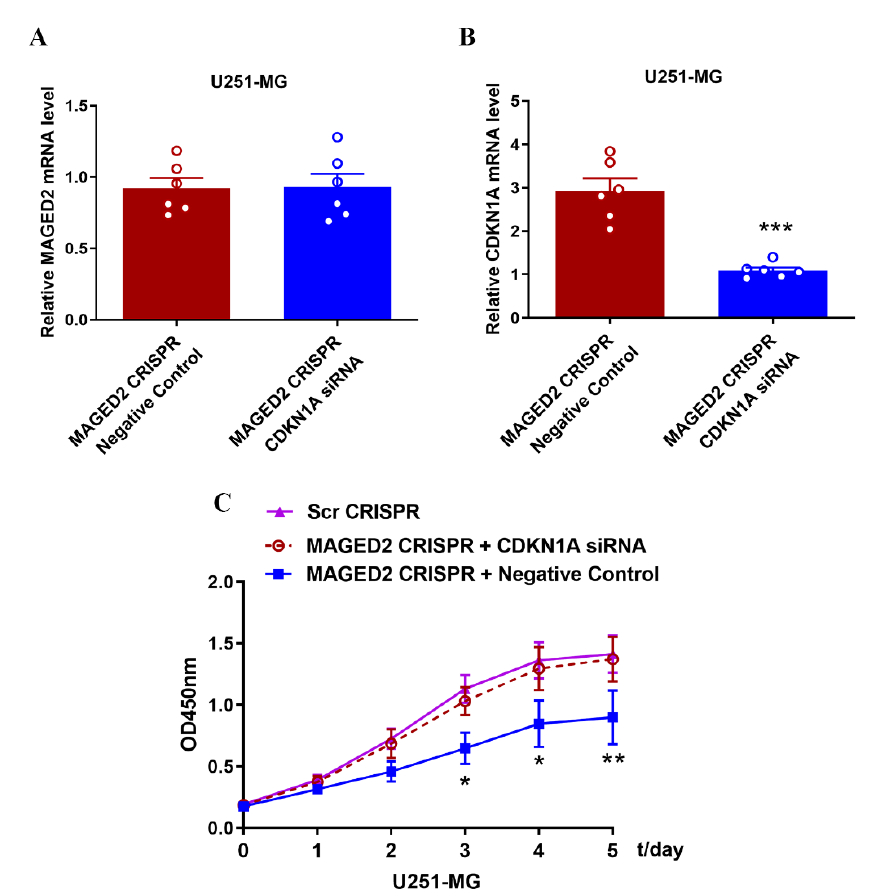
Figure 9 . Downregulation of CDKN1A expression resumes the proliferation of glioma U251-MG cells. ( A , B ) After transfection of CDKN1A siRNA in MAGED2 CRISPR U251-MG cells, MAGED2 ( A ) and CDKN1A ( B ) mRNA expression were detected by qRT-PCR, * p < 0.05, ** p < 0.01, and *** p < 0.001; n = 6/group, and the CCK-8 assay ( C ) was used to detect the proliferative capacity of glioma U251-MG cells.